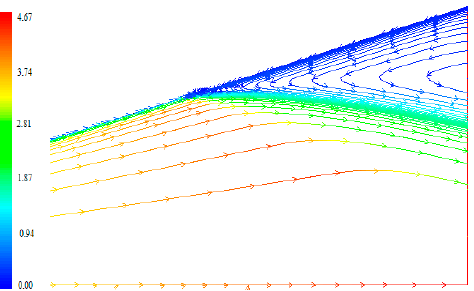
Figure 9. The Mach number streamlines’ map under ground conditions, Pc = 4.34 MPa.